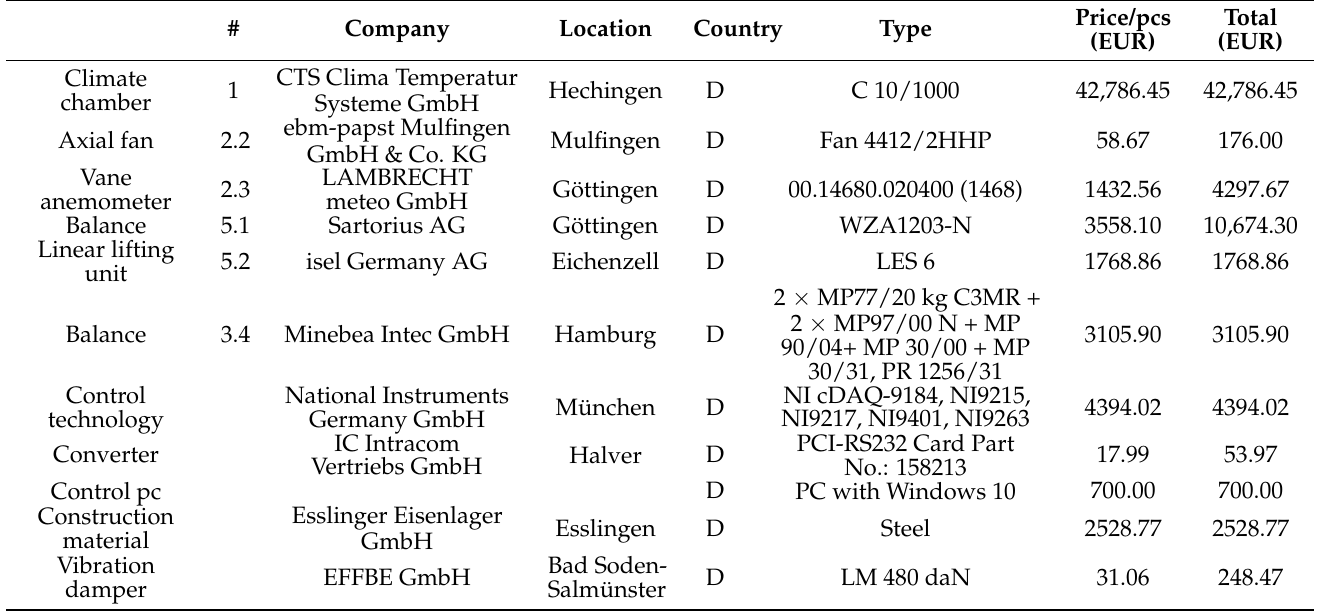
Table A2. Summary of materials